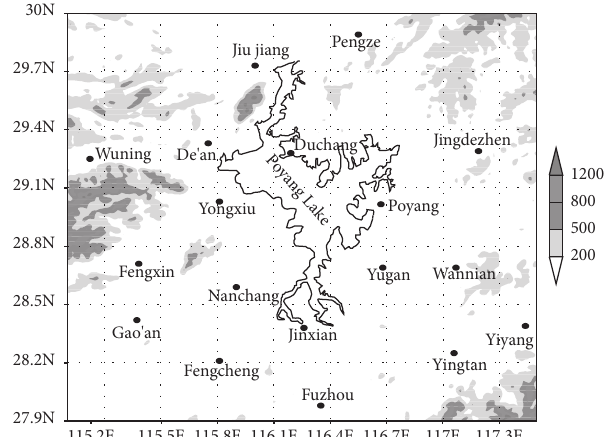
Figure 1: The GPS observation stations (solid circle) and the topography (shadow) (unit: m around PL).